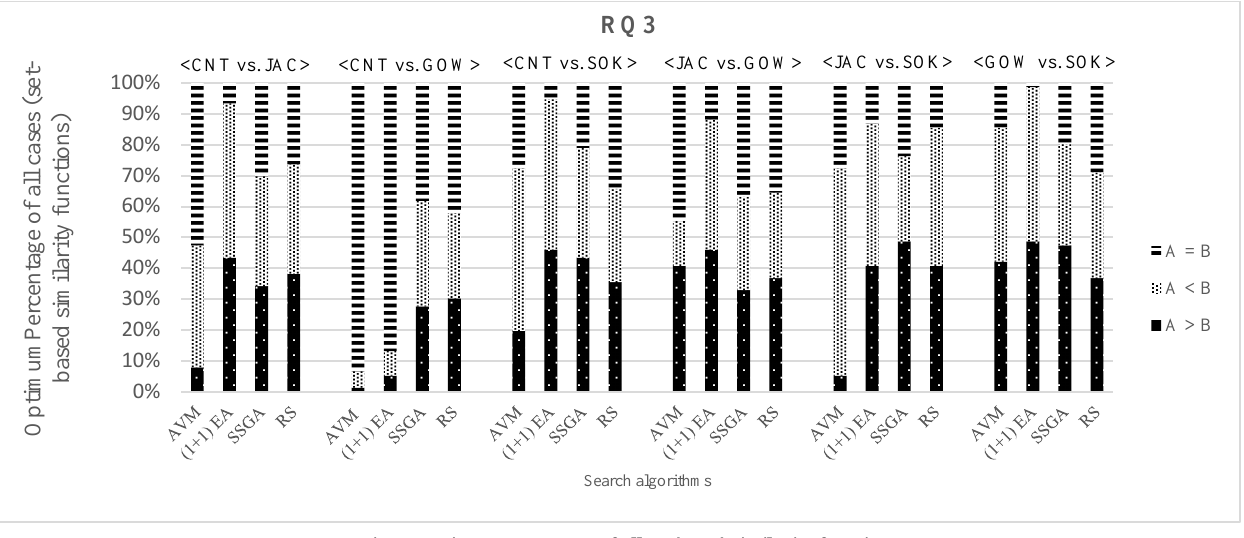
Fig. 1. OptimumPercentage of all set-based similarity functions